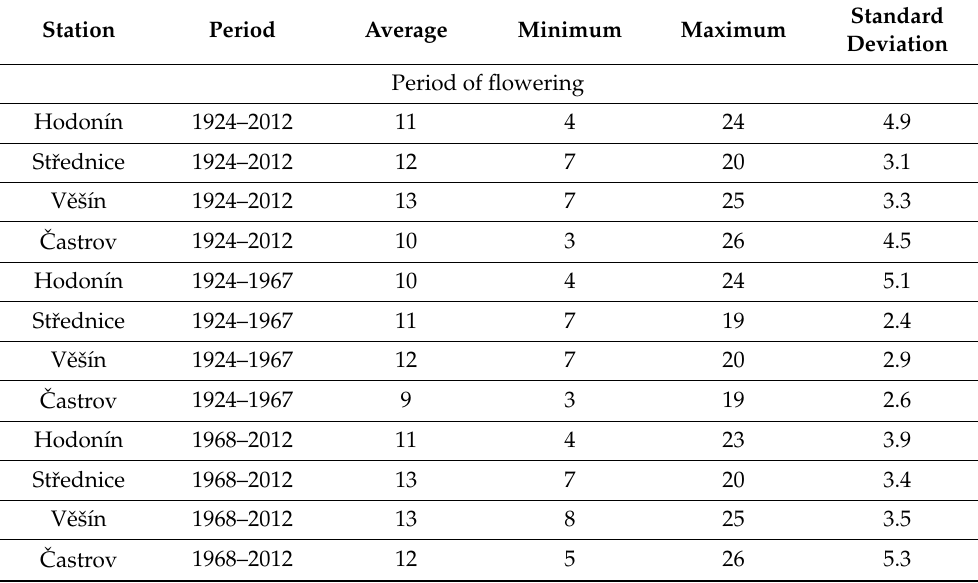
Table 4. Descriptive statistics for the period of flowering of Cerasus avium in the periods 1924–2012; 1924–1967 and 1968–2012 (in days).